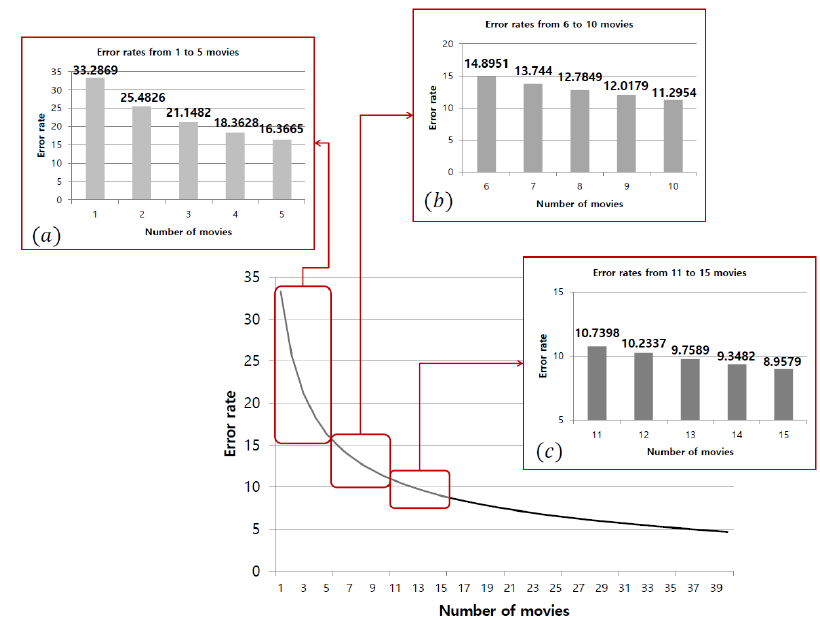
Figure 17. Error rates for different sample sizes.